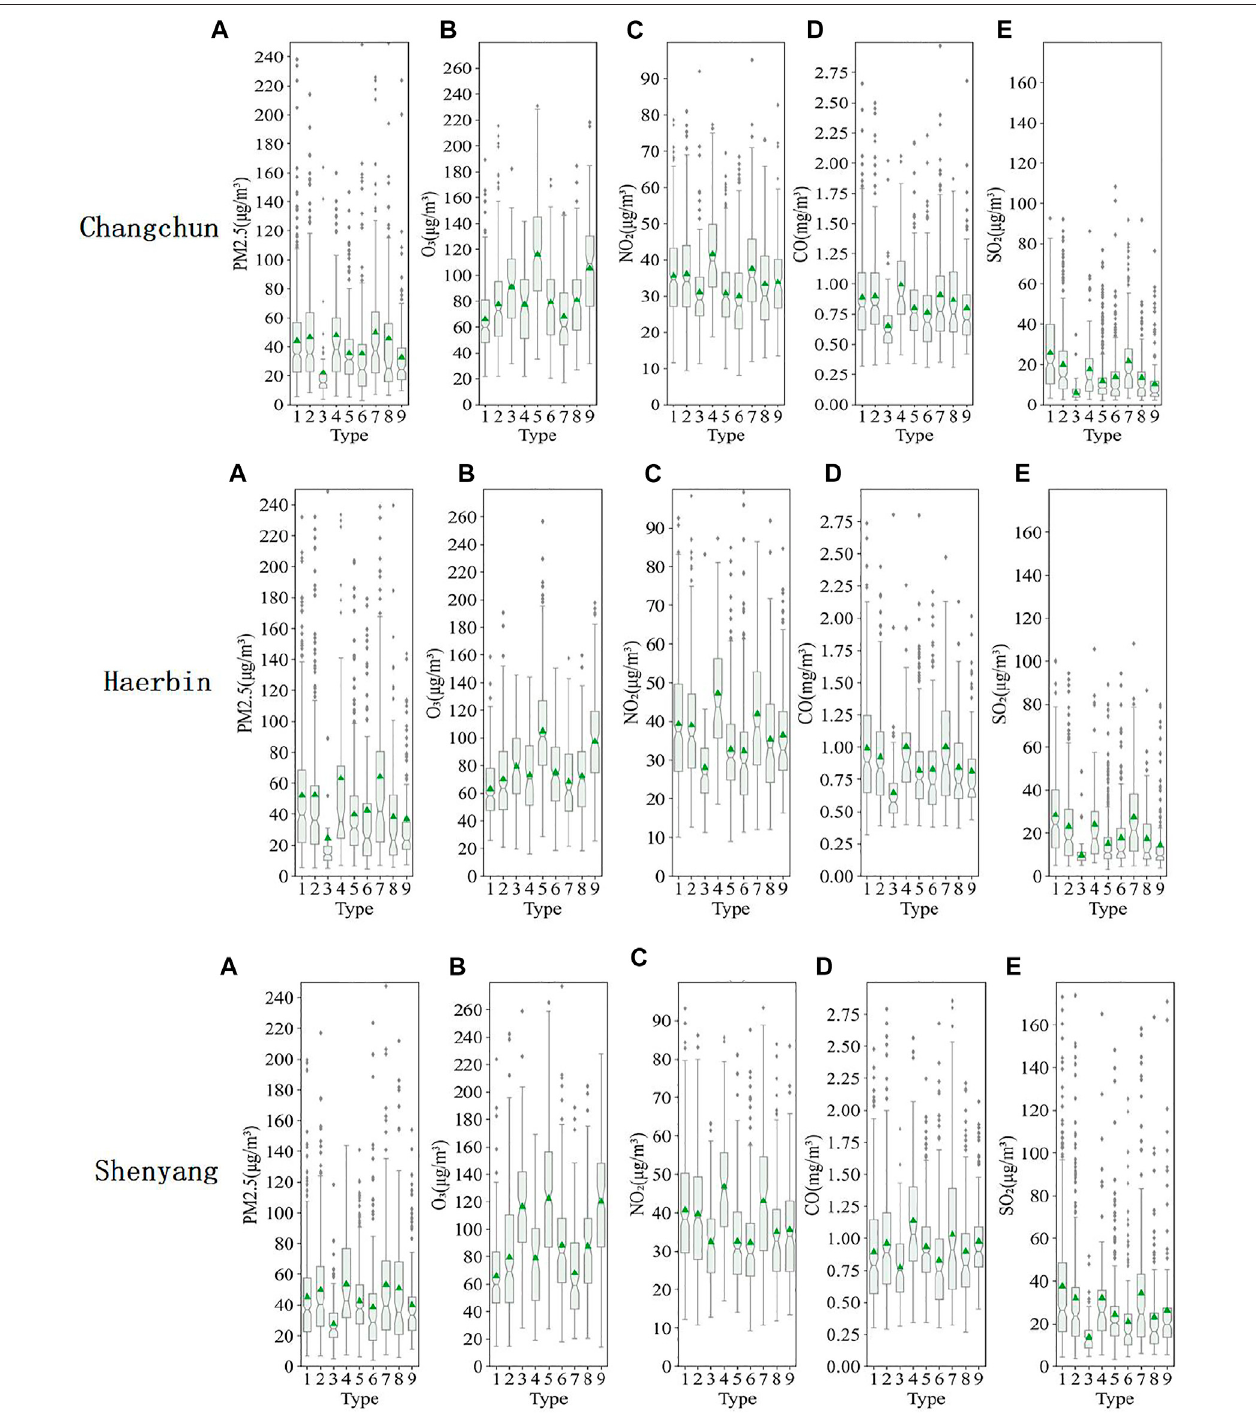
FIGURE 5 | Relationship between the nine circulation patterns and the concentration of major air pollutants in Changchun, Harbin, and Shenyang; the triangle representstheaverageconcentration,theshortlinerepresentsthemedian concentrationofpollutants,theupper shortlineoftheboxrepresentsthethird-quarter value, and the lower short line of the box represents the quarter-quarter